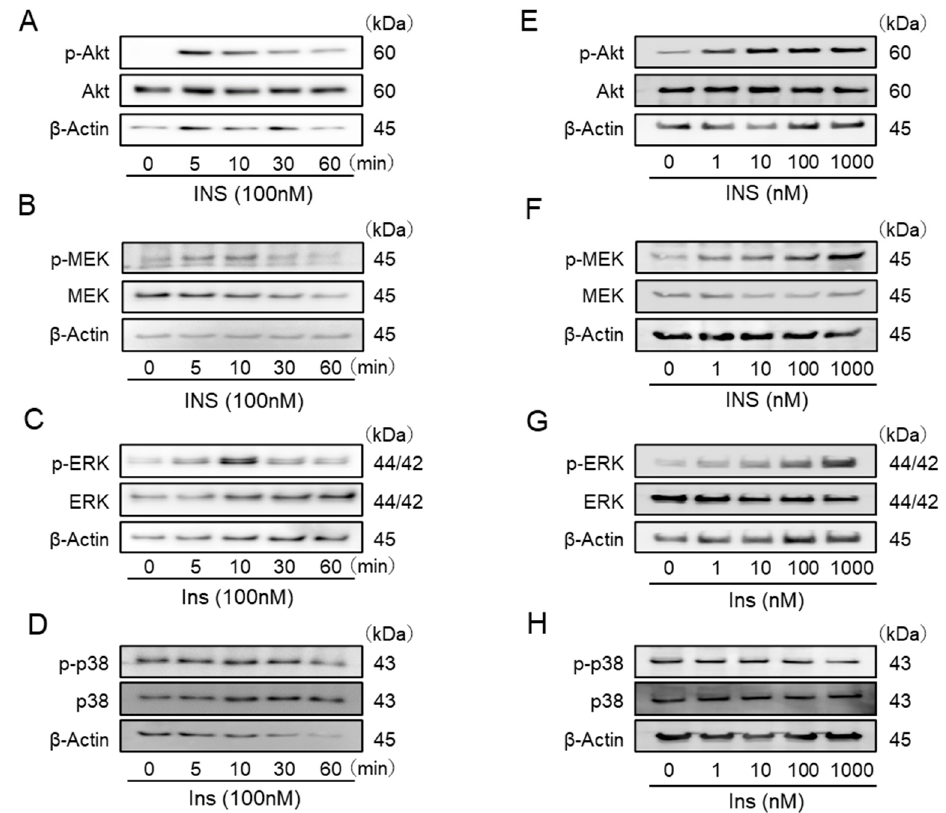
Figure 2. ( A – D ): The phosphorylation of Akt, MEK, extracellular signal-regulated kinase (ERK), and 38-mitogen-activated protein kinase (MAPK) by insulin. Insulin stimulation (100 nM) was conducted for the indicated time. ( E – H ): The concentration-dependent phosphorylation of Akt, MEK, ERK, and p38-MAPK by insulin.